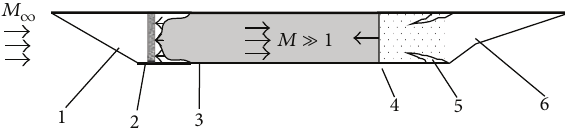
Figure 4: Idealized scheme of PDRJE.